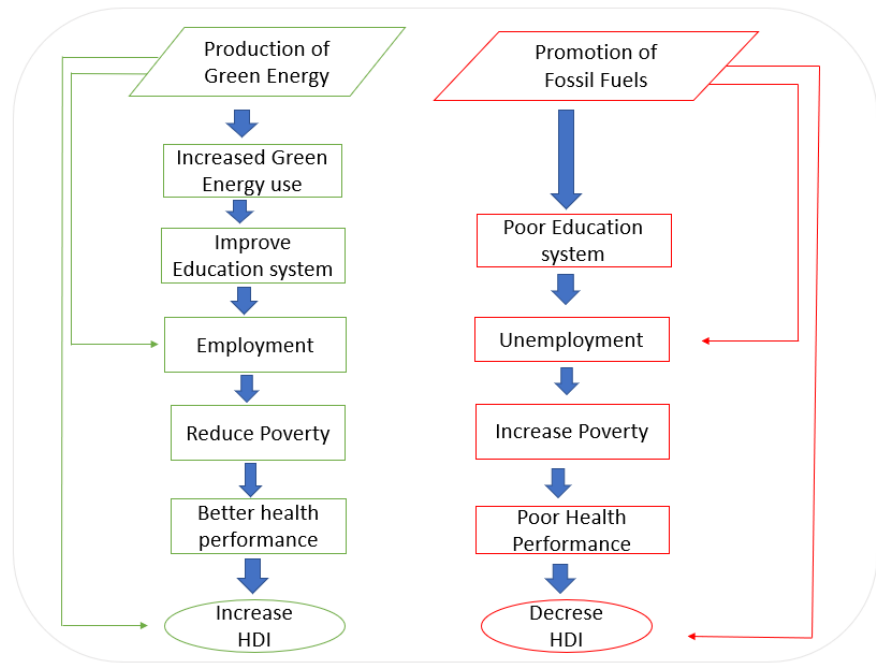
Figure 2. The theoretical model of the study. Source: Author´s representation.